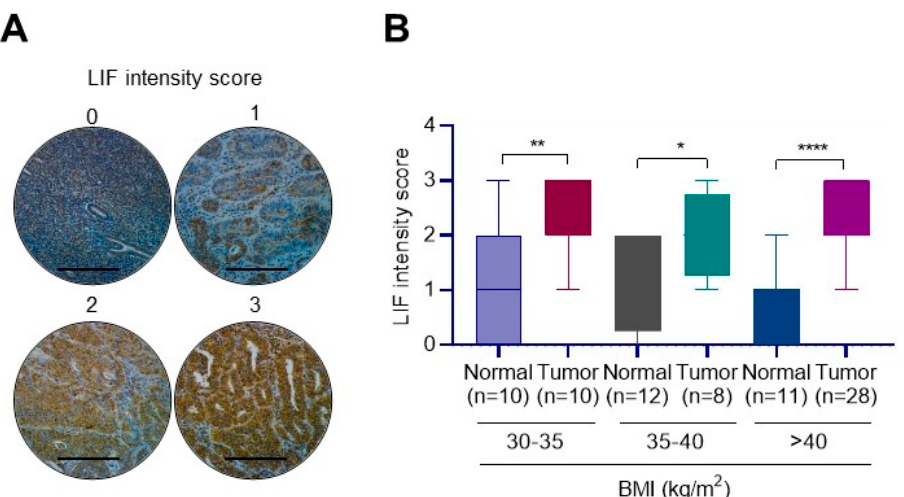
Figure 2. LIF is overexpressed in EEC. ( A ) Tissue microarray consisting of samples from patients with EEC (n = 46) and from individuals with normal endometrial tissue (n = 33) were evaluated for LIF expression, and representative IHC images are shown with LIF intensity score 0–3. ( B ) Quantitation of expression of LIF in normal and EEC tissue microarray is shown. Data are represented as mean ± SE. * p < 0.05; ** p < 0.01; **** p < 0.0001.